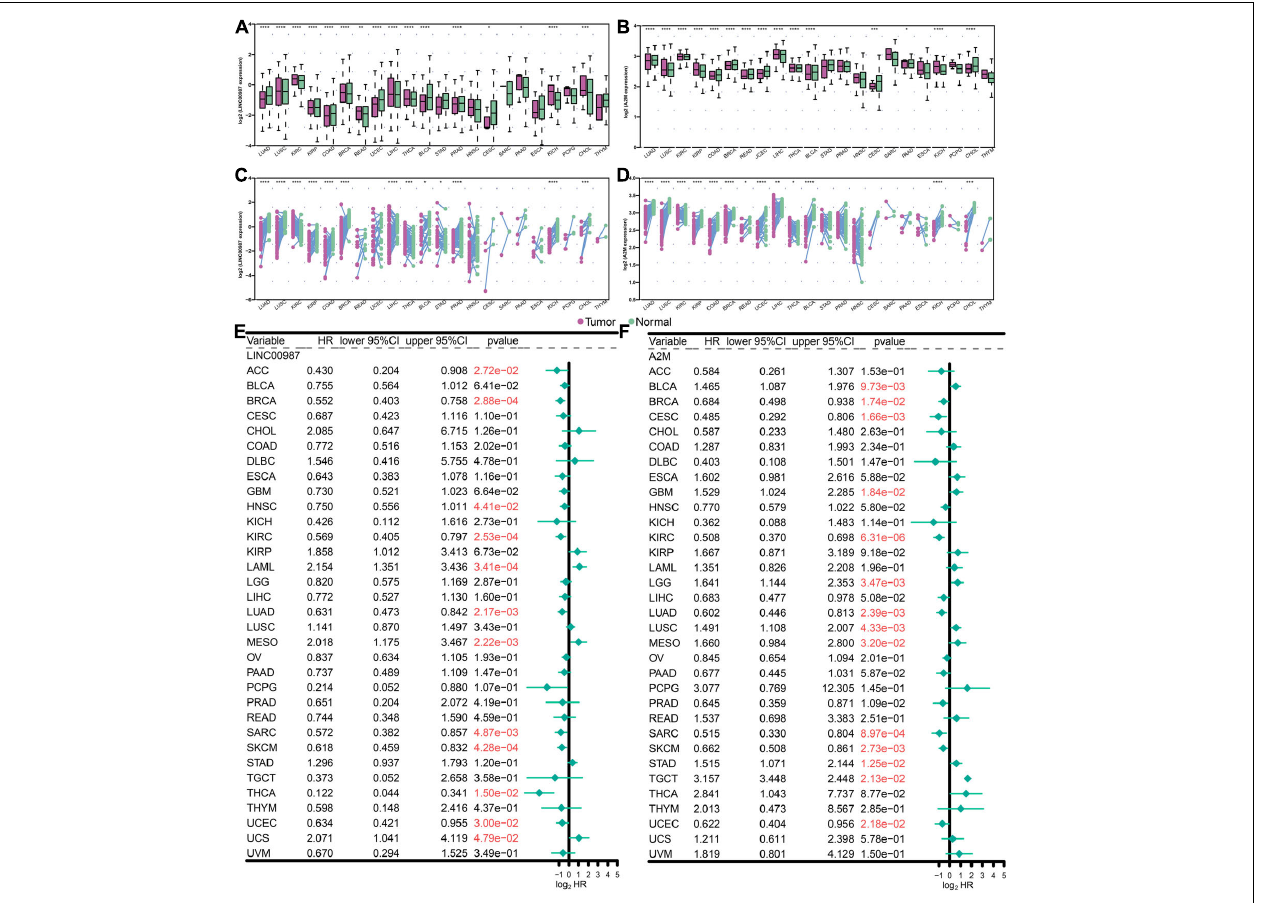
FIGURE 9 | Levels of expression and Kaplan-Meier survival analysis of LINC00987 and A2M in pan-cancer analysis. (A,B) Population differences in the expression of LINC00987 and A2M. (C,D) Pairing differences in the expression of LINC00987 and A2M. (E,F) Red values indicate statistical significance of the p value ( p < 0.05). HR hazard ratio, 95% CI 95% confidence interval, * p < 0.05, ** p < 0.01, *** p < 0.001, and **** p <